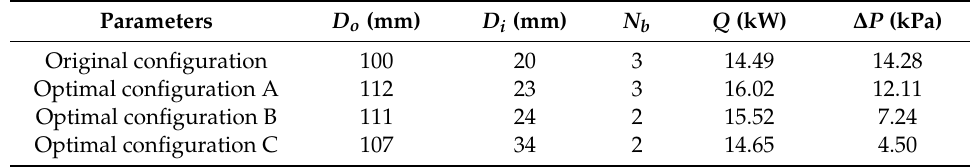
Table 3. Optimization thermohydraulic performances comparison of STHX-DDB.